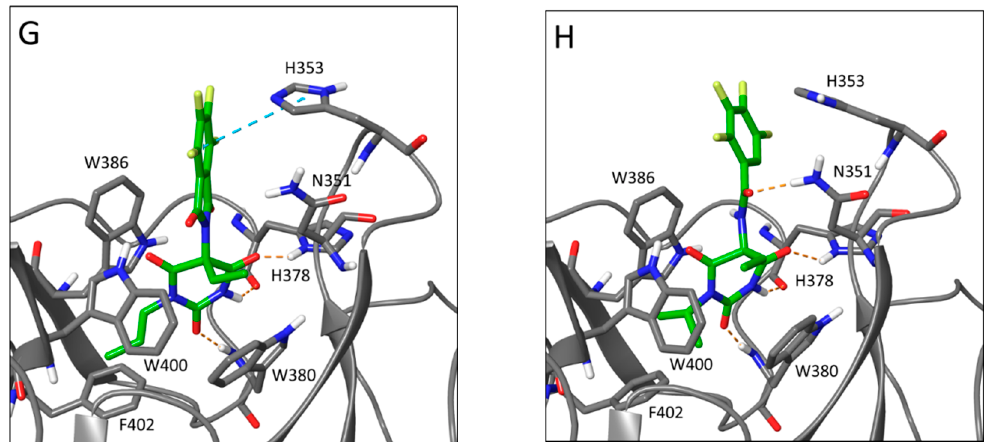
Figure 3. Thalidomide analog docking to cereblon. Hydrogen bonds are indicated by dashed orange lines, and aromatic ring stacking interactions are indicated by dashed light blue lines. ( A ) lenalidomide; ( B ) compound C4 ; ( C ) compound C44 ; ( D ) compound C55 ; ( E ) compound C83 ; ( F ) compound C86 ; ( G ) compound Gu998 ; ( H ) compound Gu992 . The glutarimide ring makes a set of conserved hydrogen bonds to Trp 380 N and His 378 N δ and O, and the phthalimide ring can hydrogen bond to Asn 351.